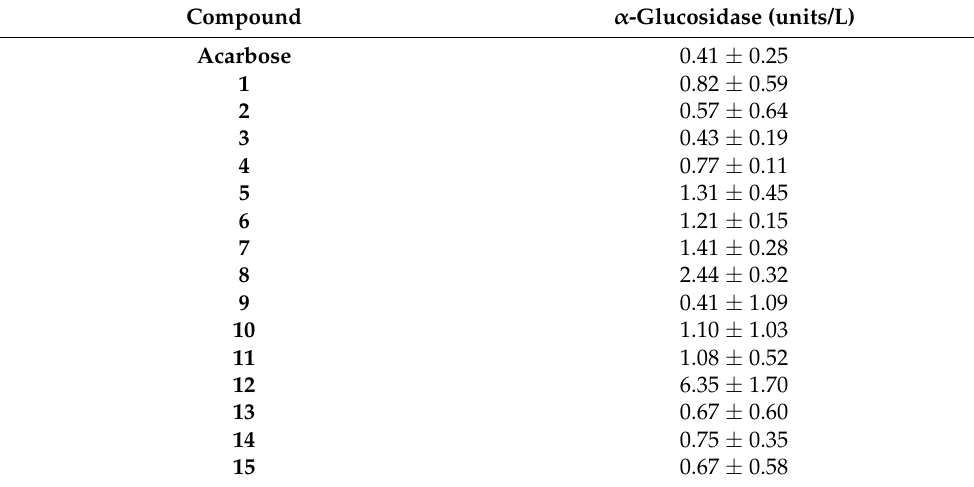
Table 3. α -glucosidase activity of compounds (20 µ M) isolated from C. bignonioides . Compound α -Glucosidase (units/L) Acarbose 0.41 ± 0.25 0.82 ±